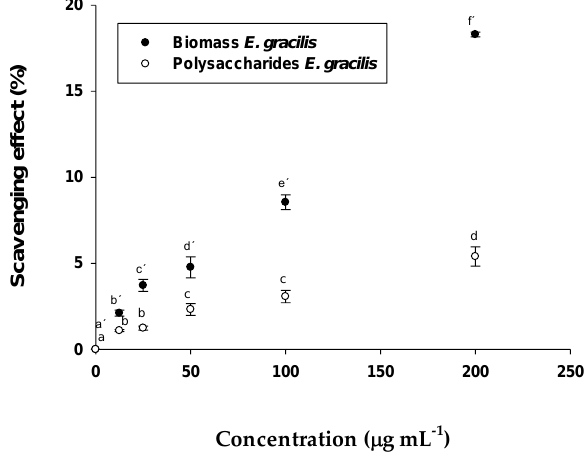
Figure 3. Scavenging effects % of the sample on ABTS radical. The data are the mean of 3 replicate measurements ± standard error. Similar letters indicate no significant differences (Tukey, p < 0.05) between the different concentrations. The antioxidant activity assay, using the DPPH method, for the biomass from E. gra- cilis showed the highest antioxidant activity at the concentration of 200 µg mL − 1 with a value of 17.79 ± 0.57%, although at the studied concentrations, there was not much varia- tion between the data obtained from this method. (Figure 4).